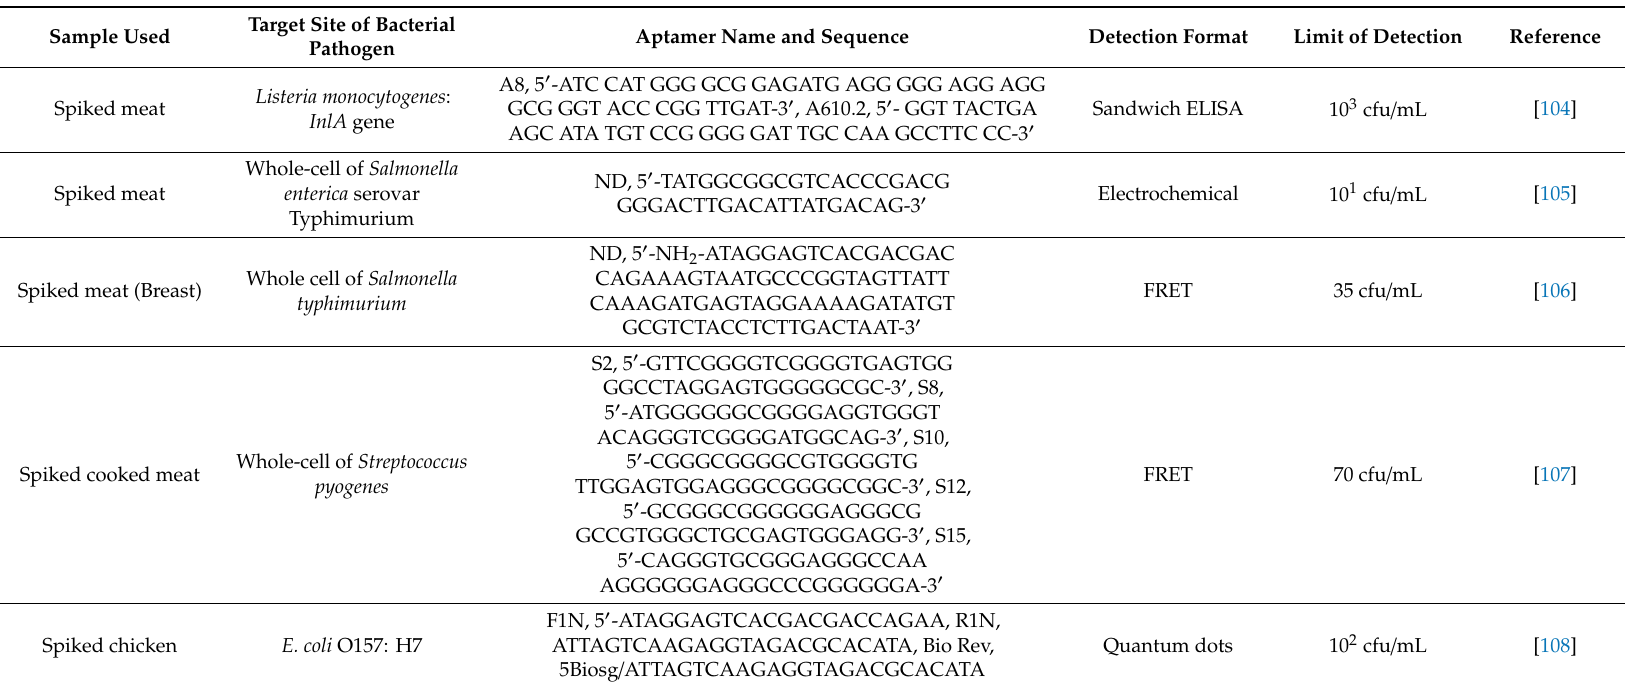
Table 7. Aptamers based approaches used for the detection of chicken-borne